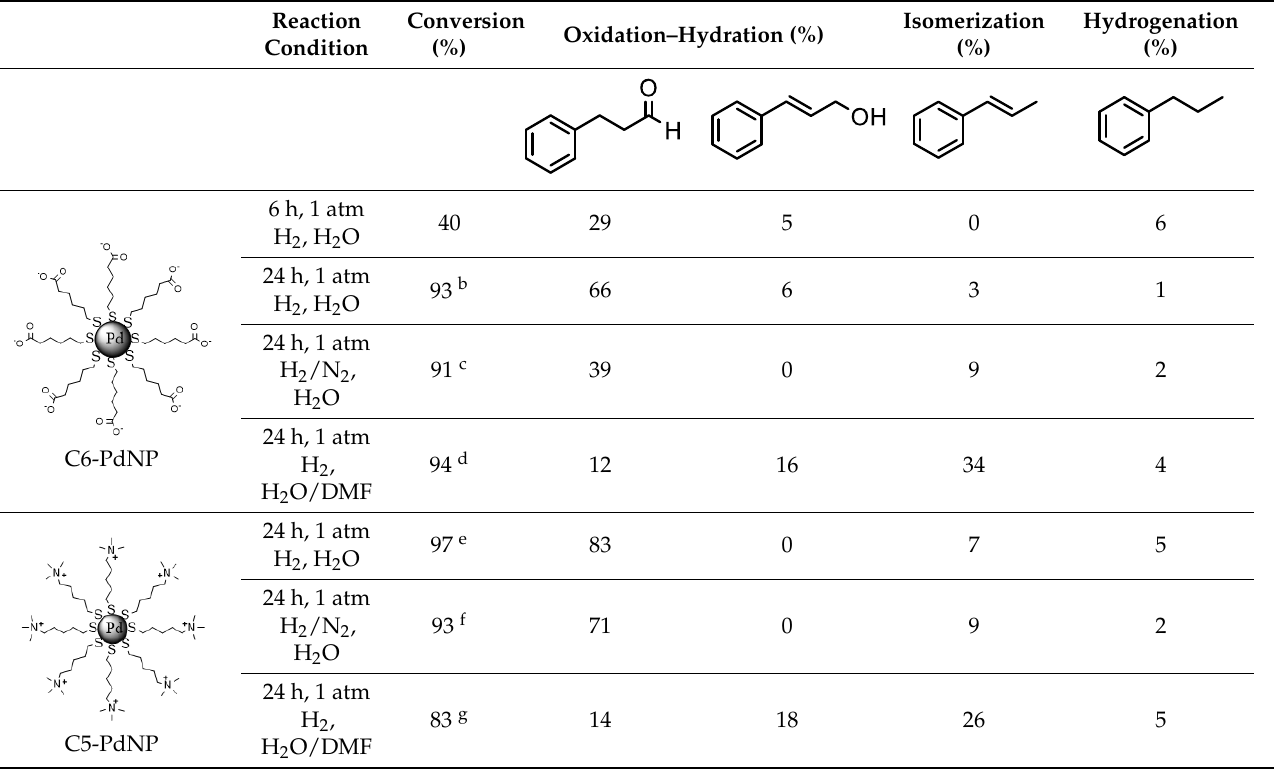
Table 1. Catalysis results for the anti-Markovnikov oxidation of allyl benzene by water-soluble Pd nanoparticles (10 mol% Pd) in water at room temperature a . Reaction